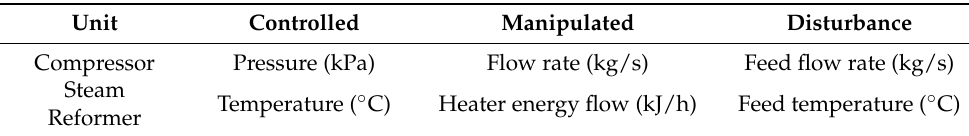
Table 4. Variable